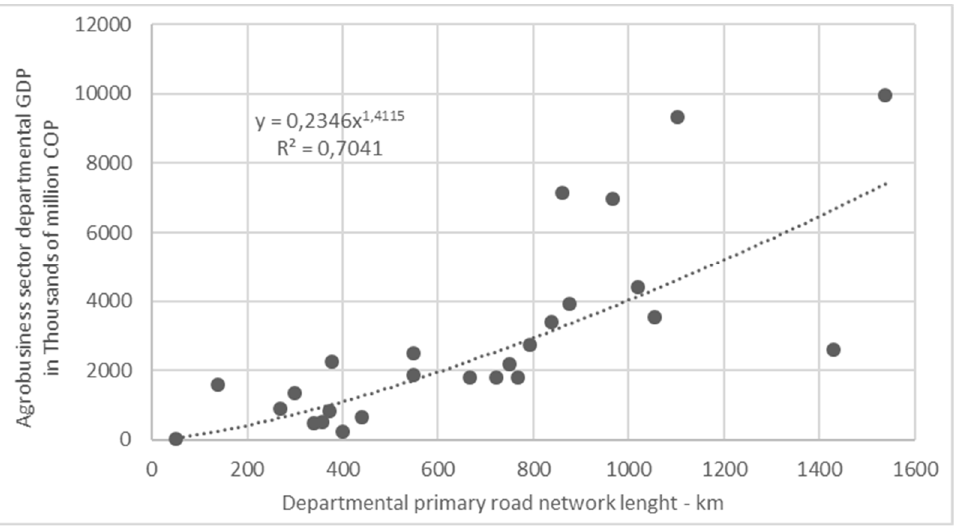
Figure 7. Potential regression between agribusiness sector GDP and primary roadway network length according to the department.